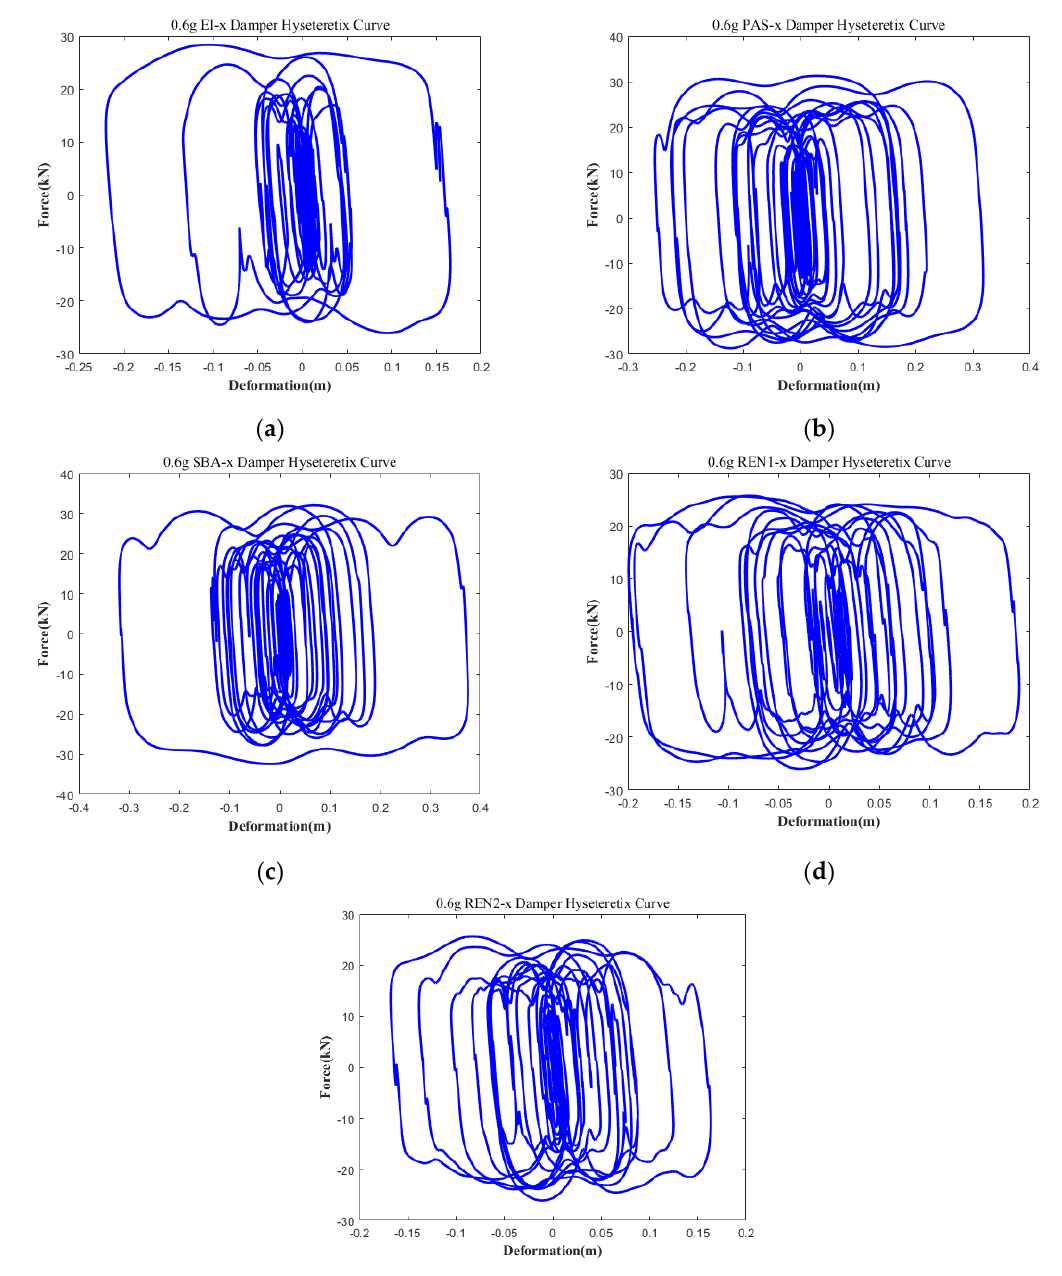
Figure 27. Hysteretic curves of viscous dampers under different earthquake waves at a peak of 0.6 g. ( a ) Hysteresis loops under EL seismic wave at peak of 0.6 g. ( b ) Hysteresis loops under PAS seismic wave at peak of 0.6 g. ( c ) Hysteresis loops under SBA seismic wave at peak of 0.6 g. ( d ) Hysteresis loops under REN1 seismic wave at peak of 0.6 g. ( e ) Hysteresis loops under REN2 seismic wave at peak of 0.6 g